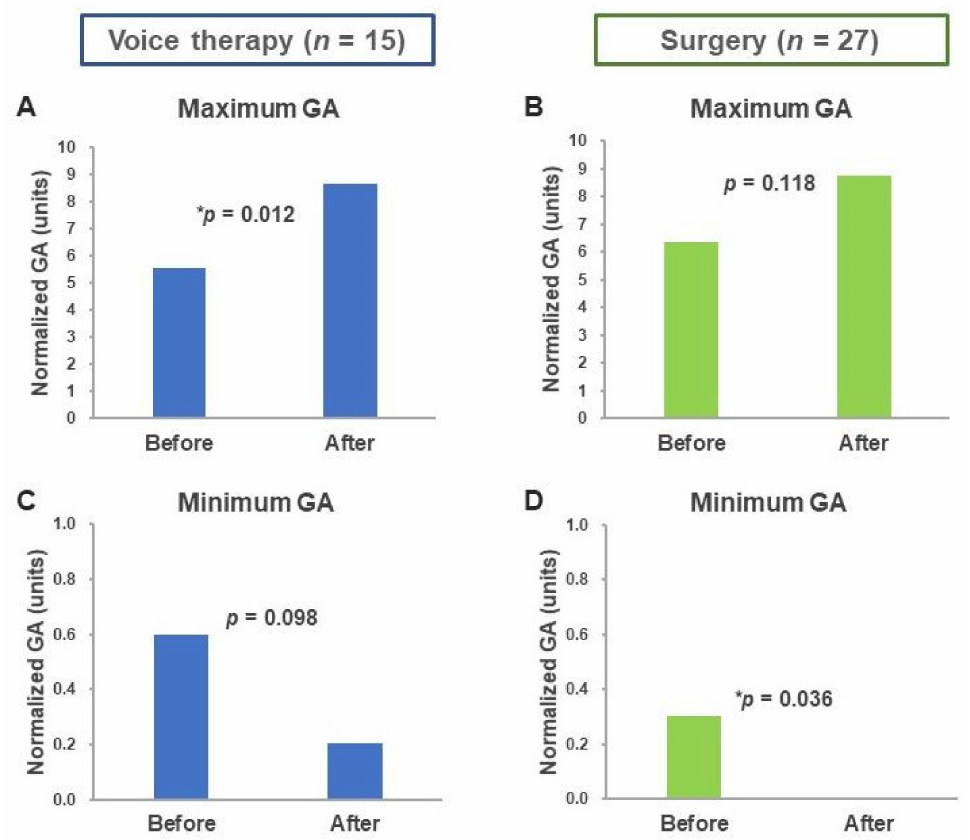
Figure 3. Changes in maximum and minimum GAs before and after treatment. Changes in maximum GA before and after ( A ) voice therapy and ( B ) surgery. Changes in minimum GA before and after ( C ) voice therapy and ( D ) surgery. Abbreviation: GA, glottal area. * p <